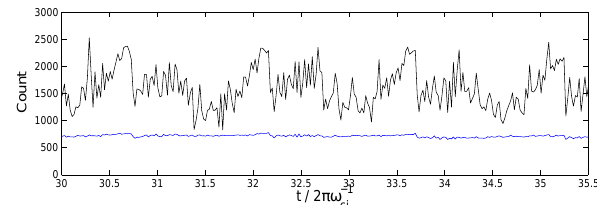
Fig. 7. Reflection rates over a series of reformation cycles. Solar wind protons are in black, and pickup protons in blue. Counts are of particles upstream of the minima in R E x dx associated with the shock front, with velocities, in the case of solar wind ions directed in the direction of shock propagation, or for pickup ions, outside of the initial injected spherical distribution. Pickup ion counts are normalised to solar wind counts.